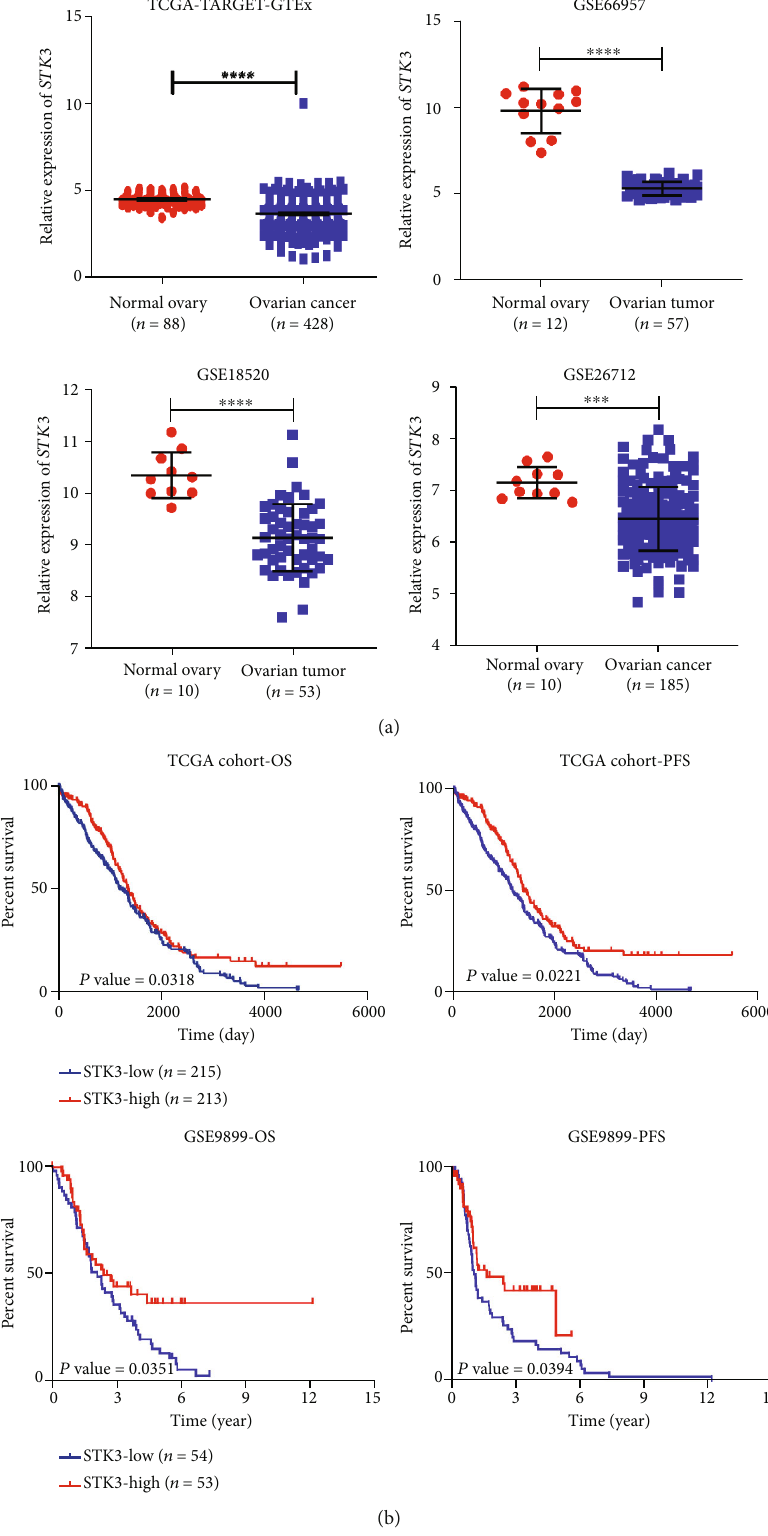
Figure 1: Database analysis showed that STK3 was downregulated in ovarian cancer tissues, and the overexpression of STK3 was closely related to better prognosis. (a) Analysis of the mRNA level expression of STK3 in the TCGA database and GEO database (two-tailed Student ’ s t -test, ∗∗∗ P < 0 : 001 ; ∗∗∗∗ P < 0 : 0001 ). (b) Analysis of the overall survival period and progression-free survival period according to the STK3 expression in the TCGA database and GEO database (log-rank